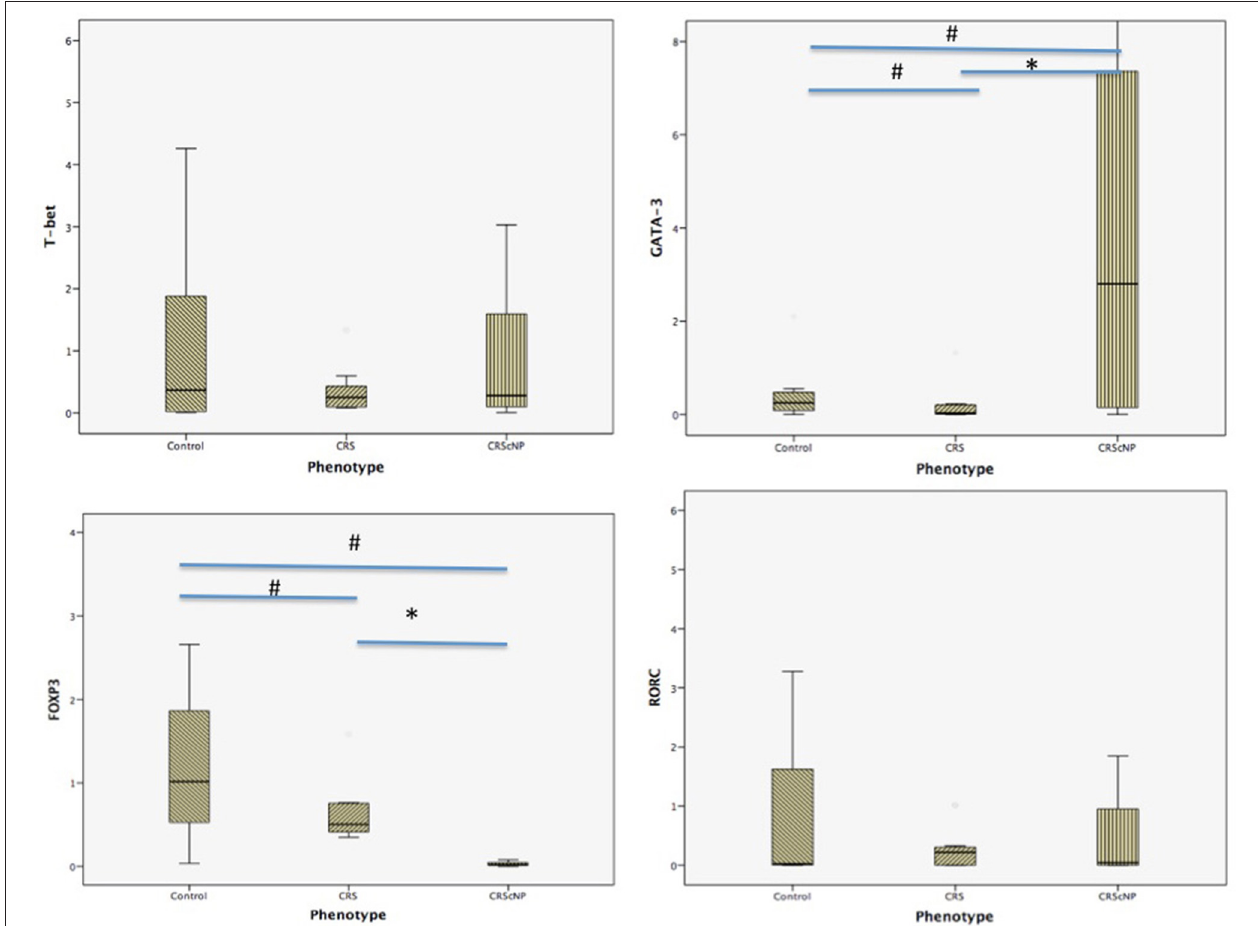
FIGURE 1 | Comparison of each transcription factor among phenotypes (median [IQR]). CRScNP, chronic rhinosinusitis with polyp; CRS, chronic rhinosinusitis; T-bet, T-box transcription factor; GATA-3, GATA binding protein 3; FOXP3, forkhead box P3; RORC, retinoic acid-related orphan receptor C. *Statistically significant between CRScNP and CRS # Statistically significant comparing to Control group.